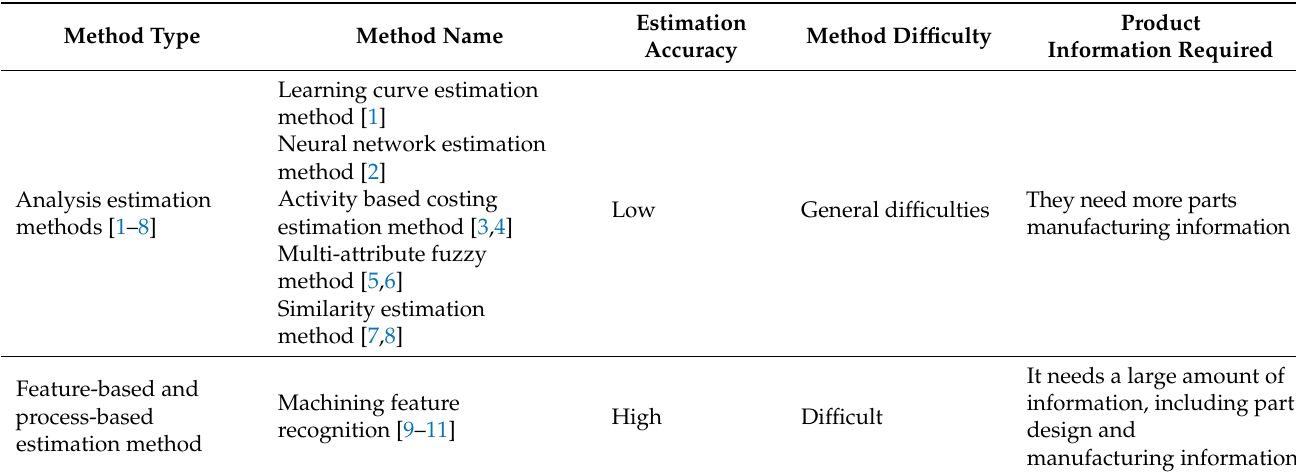
Table 1. Comparison of various estimation